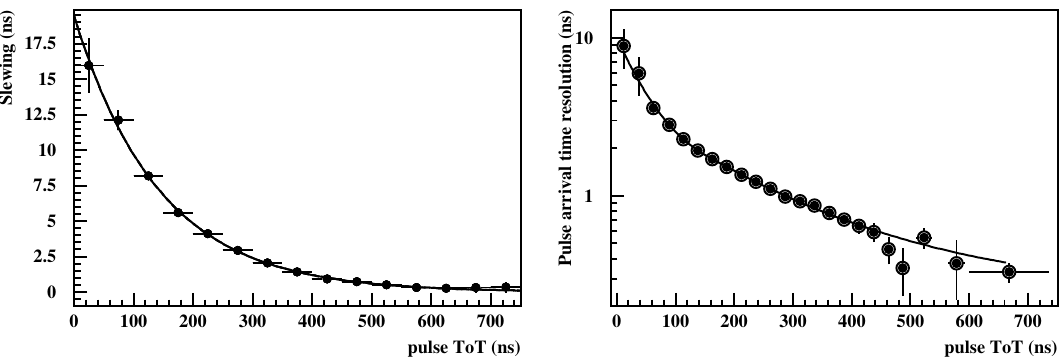
Figure 7. ( Left ): The systematic timing shift (slewing) vs. the pulse ToT. The line is the fit of the experimental points with an exponential function. ( Right ): The pulse arrival time resolution vs. the pulse ToT. The line is the fit of the experimental points with a two-part function, each of the form a + e b + cx + dx 2 and coinciding at ToT